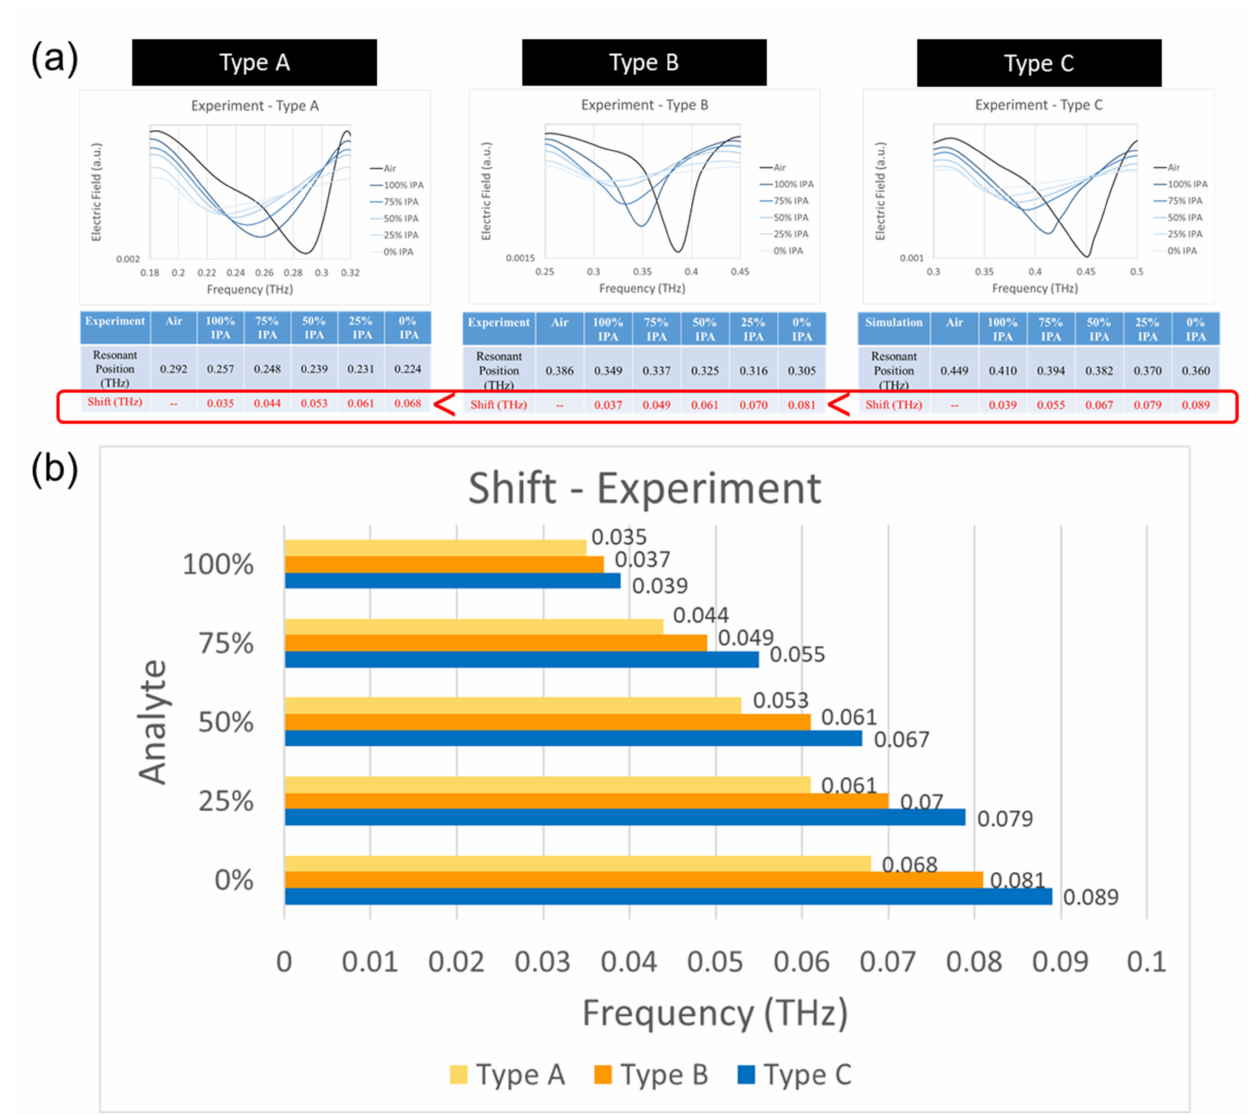
Figure 8. ( a ) Experimental results of different concentrations of IPA in Type A, B, and C chips. ( b ) Shift comparison chart for Type A, B, and C